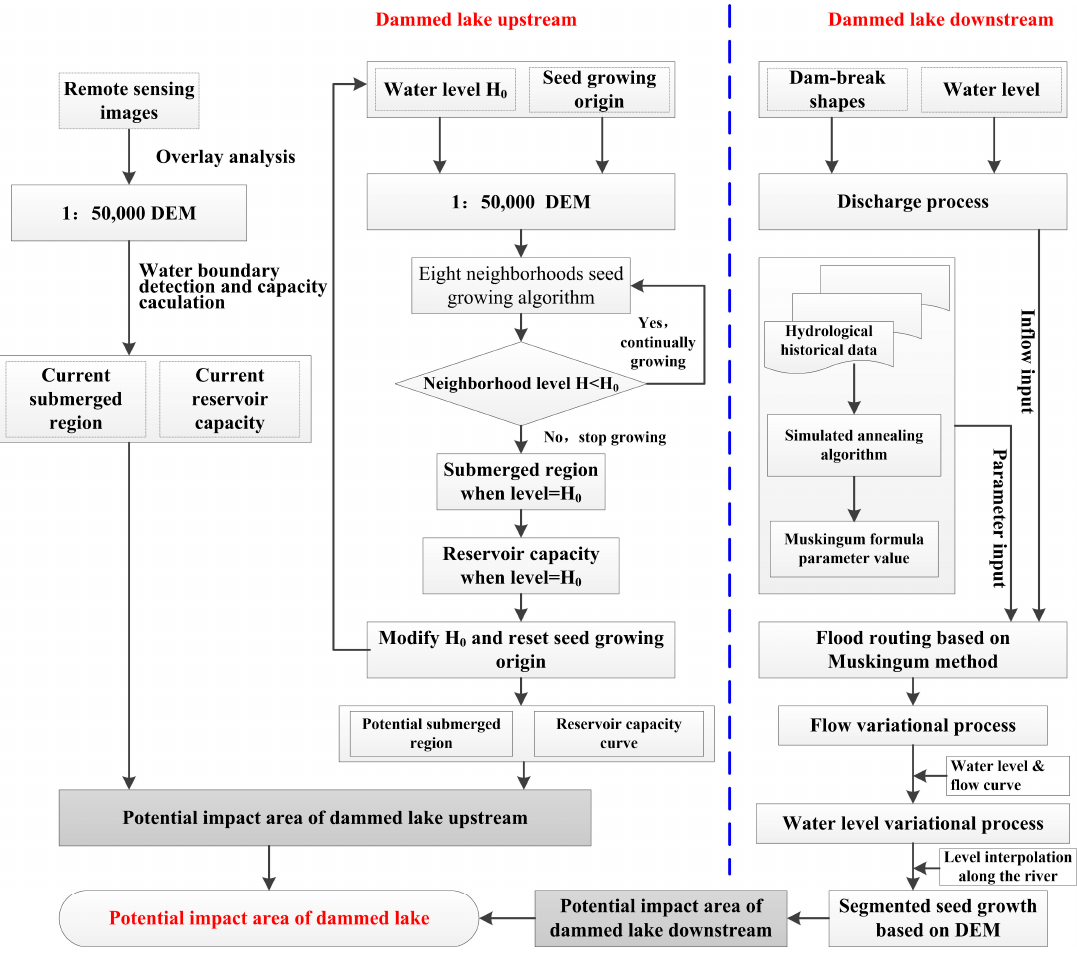
Figure 2. Research flow chart.